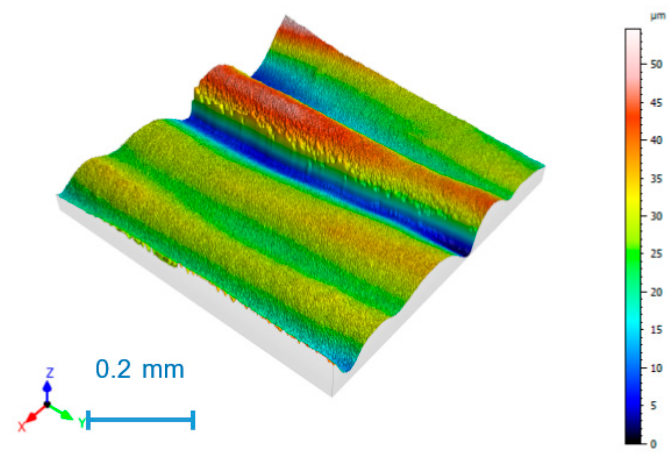
Figure 4. Surface topography for experiment 3.